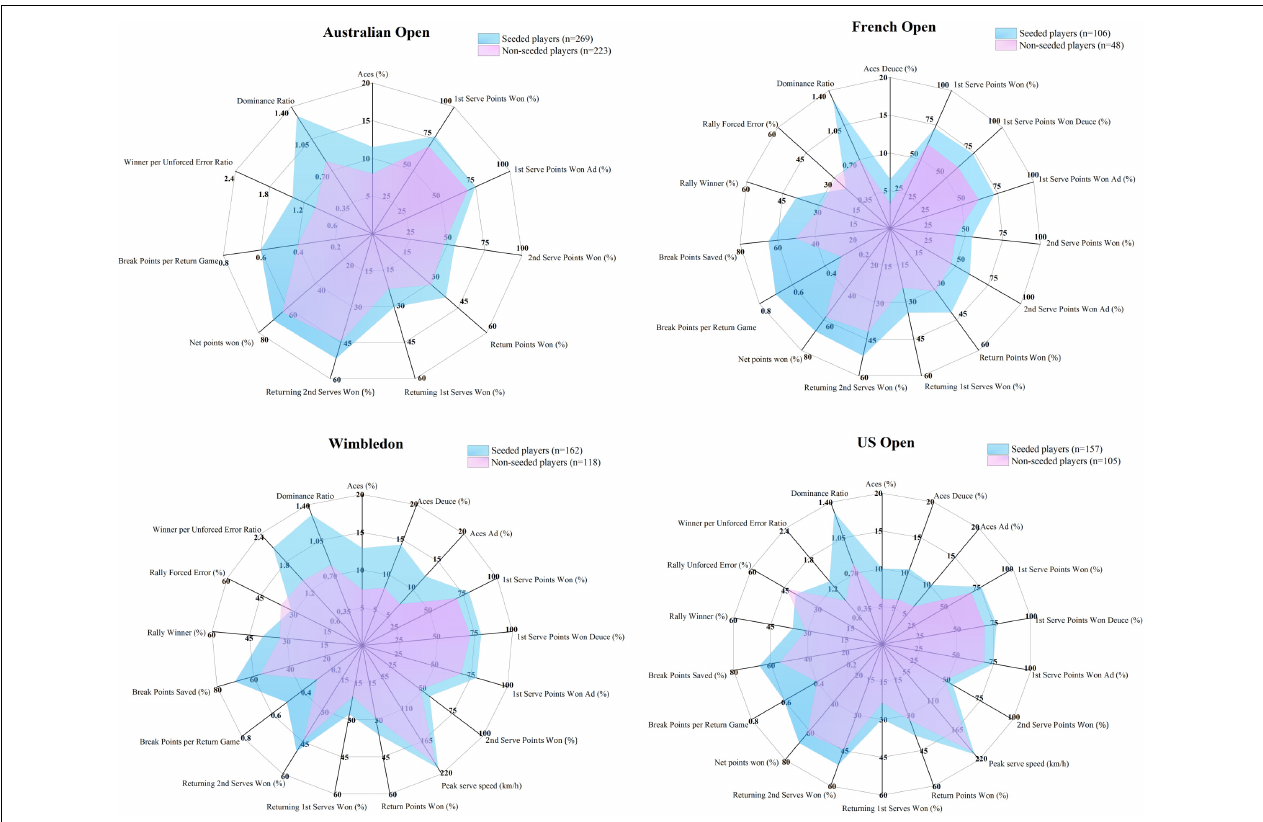
FIGURE 2 | Performance profiles of two player groups using key indicators during the four Grand Slams. Each indicator was charted according to the corresponding